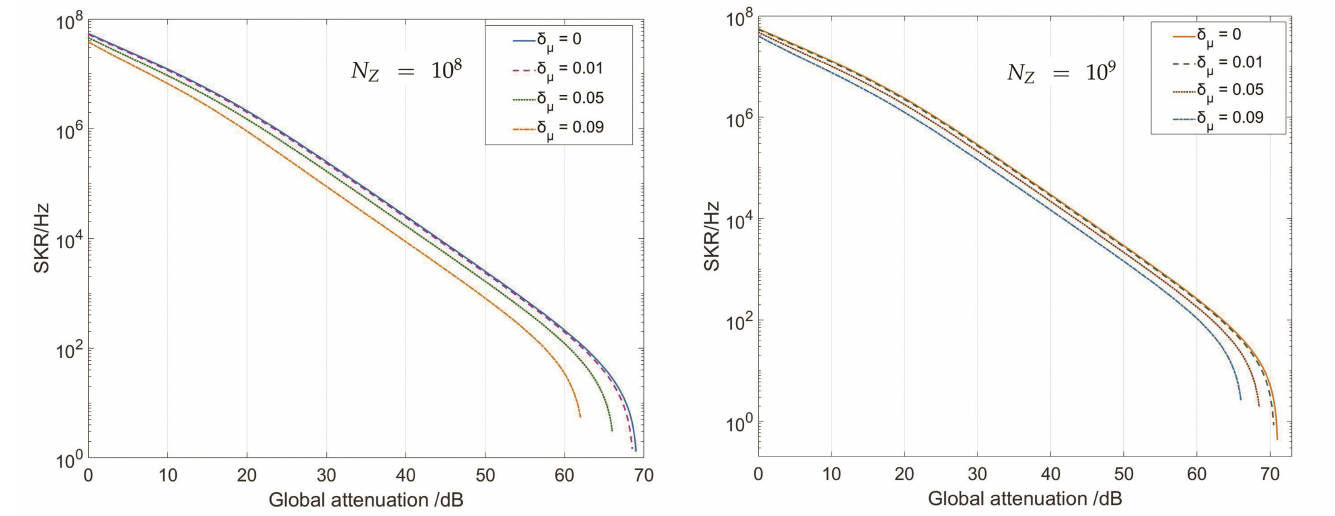
Figure 2. (Color online) Secret key rate vs. global attenuation for N Z = 10 8 and N Z = 10 9 with δ µ = 0, 0.01, 0.05,